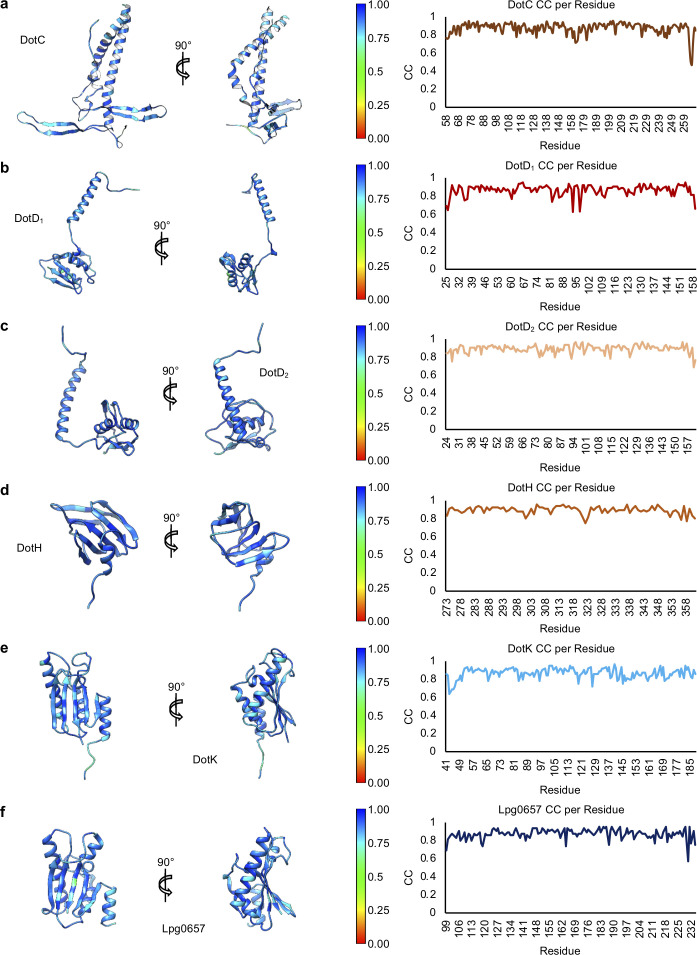
Model-map correlation for each protein within the OMC.(a–f) The correlation coefficient for each protein within the OMC is depicted as a heat map on the corresponding structure and is plotted against the residue number.